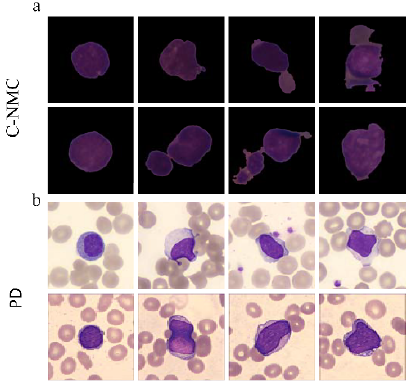
Figure 1. Cell image samples from the dataset. ( a ) C-NMC dataset: row #1 shows lymphoblasts, and row #2 shows normal leukocytes; ( b ) PD dataset: row #1 shows lymphoblasts, and row #2 shows normal leukocytes. The classification of lymphocytes is nontrivial even for experienced hematopathologists.